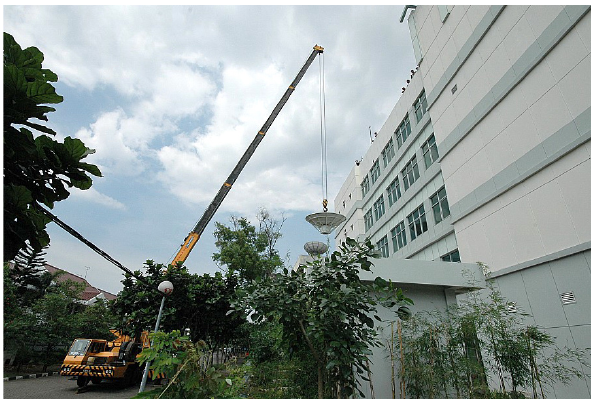
Fig. 19. The term “VSAT” (Very Small Aperture Terminal) may be misleading: considerable logistical effort was involved in the deployment of both the sensor and center to center communication